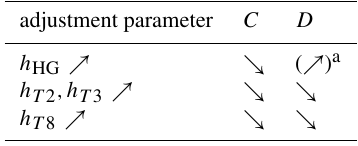
Table 1. Overview of the adjustment concept. adjustment parameter